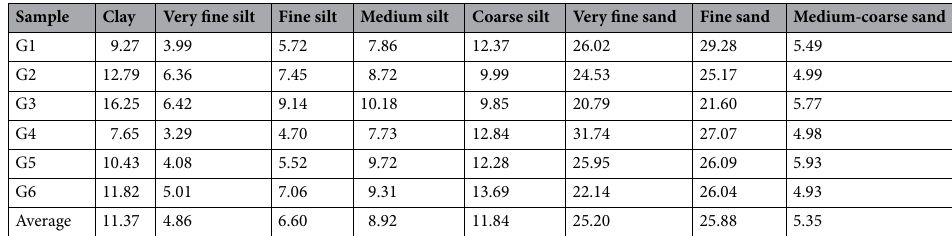
Table 3. The particle size composition of field